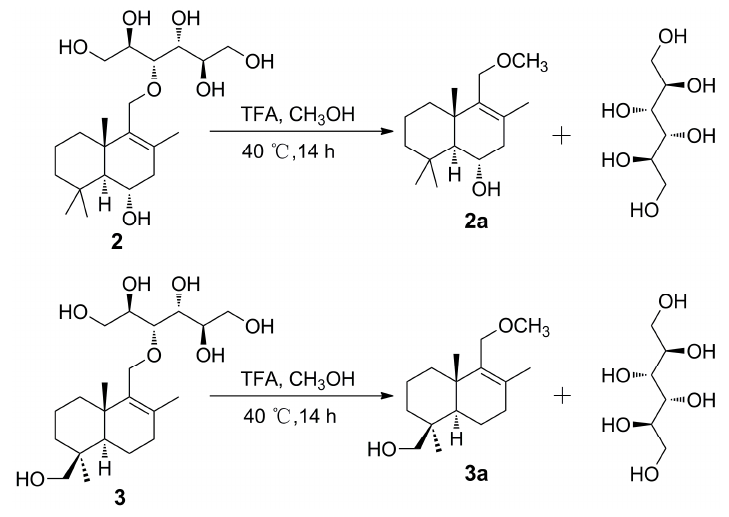
Figure 4. Acid hydrolysis of 2 and 3 .